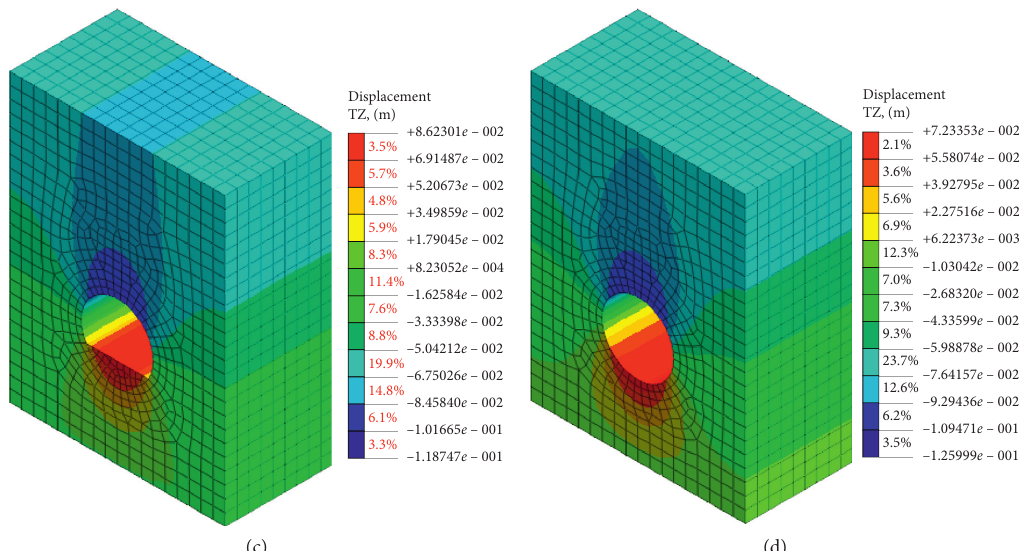
Figure 15: Vertical displacement cloud map of the ground caused by tunnel excavation without cavity. (a) Step 1. (b) Step 2. (c) Step 3. (d) Step